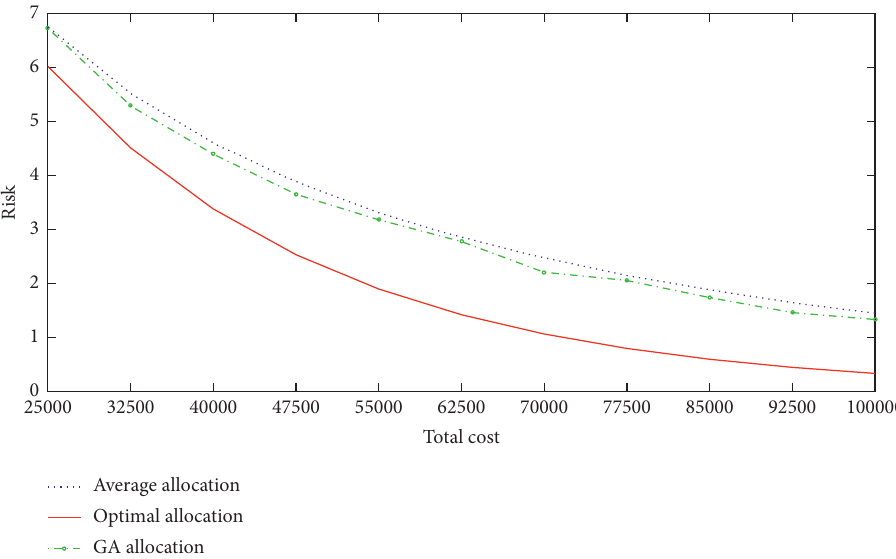
Figure 6: Illustration of the optimal cost allocation